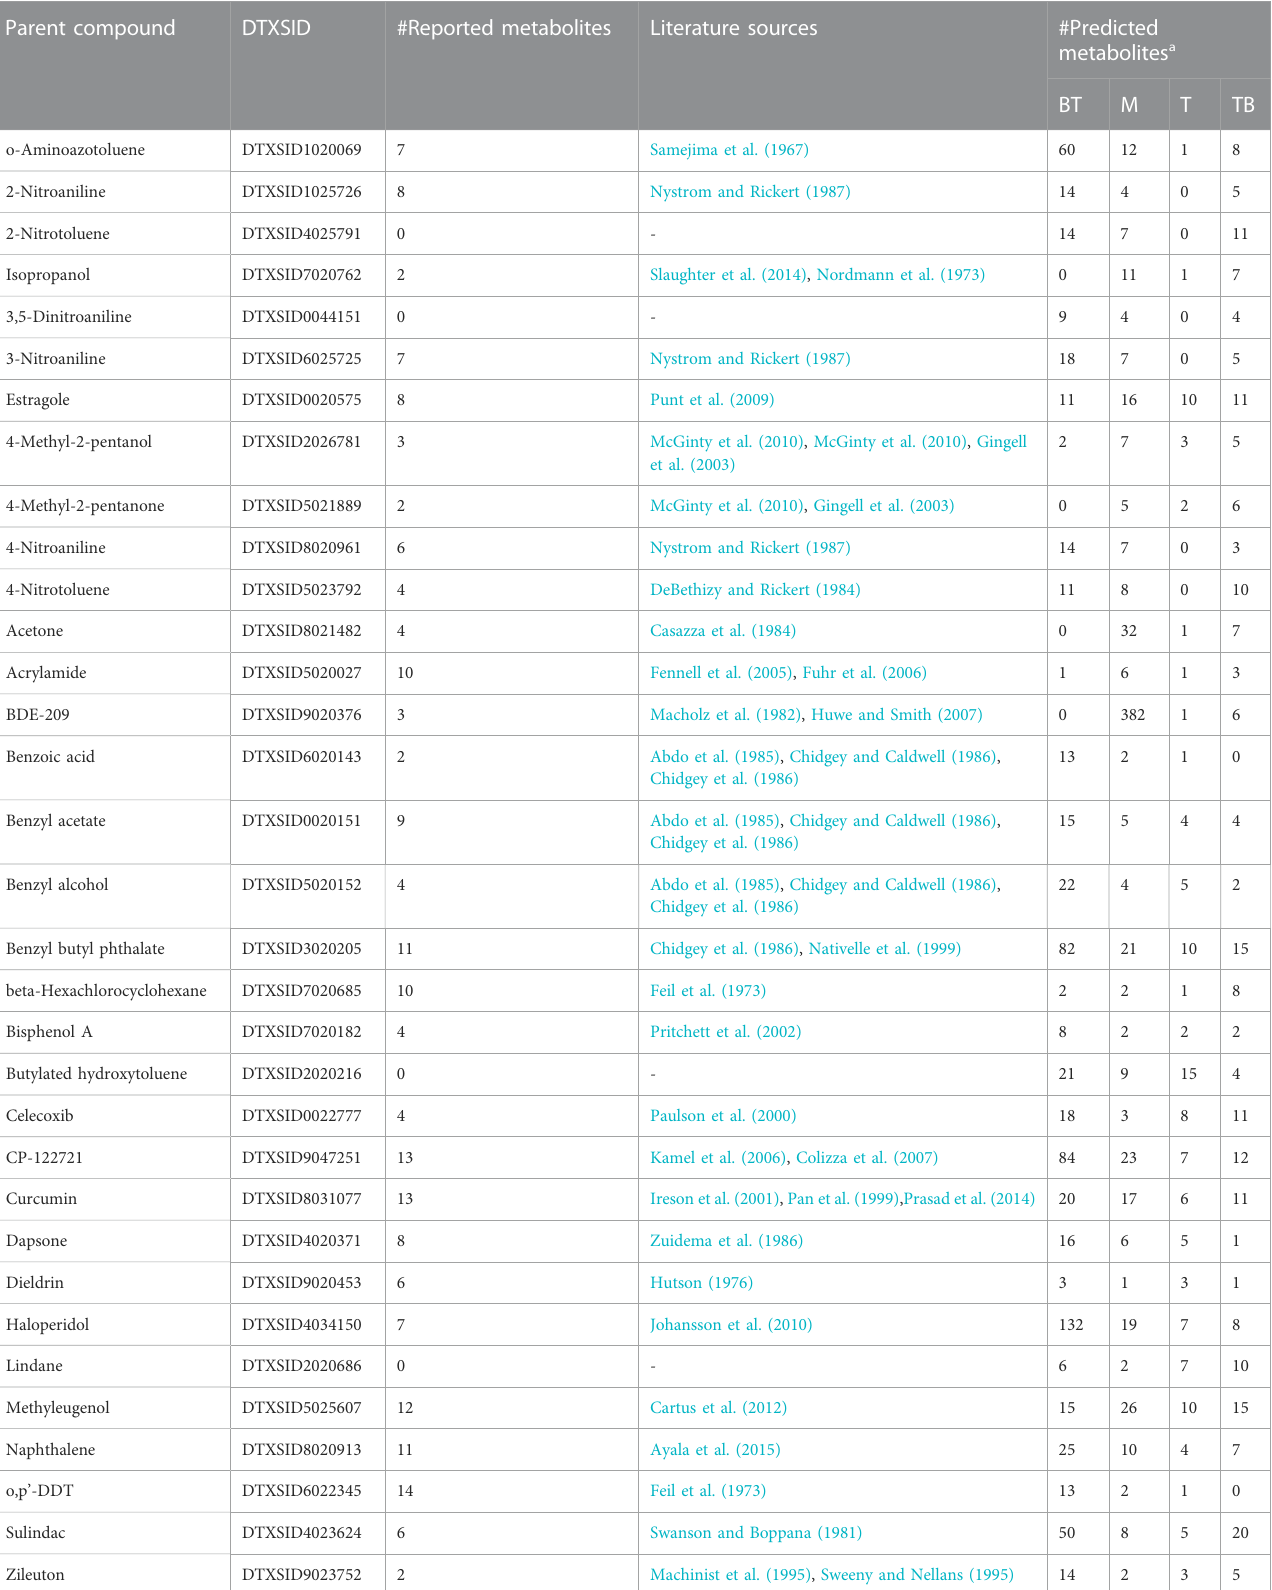
TABLE 1 Summary of reported and predicted metabolites for each parent